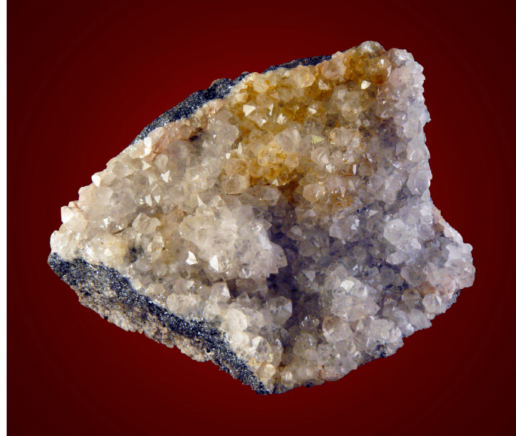
Figure 22. Quartz and hematite, Toothaker Creek prospect. 13 cm. Chamberlain Collection, NYSM 14201.